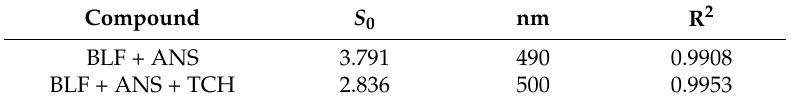
Table 6. The values of the surface hydrophobicity of the bLf-ANS system and the bLf-TCH-ANS